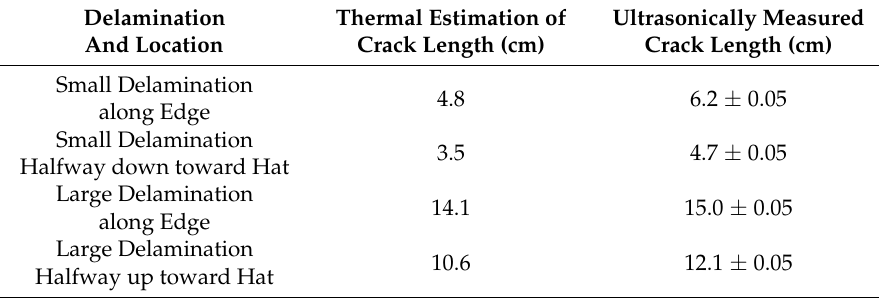
Table 2. Comparison of Thermal to Ultrasound Measurement of Crack